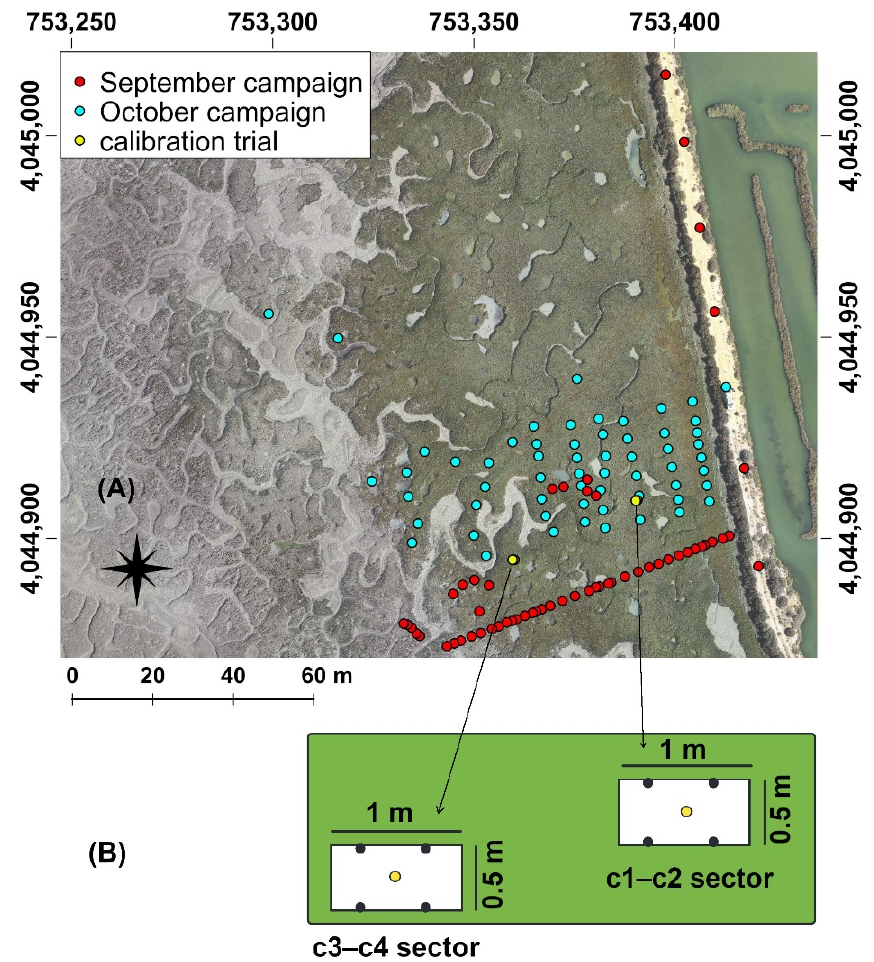
Figure 6. ( A ) Distribution of ground control points (GCP) over the surveyed area. The sectors for the calibration trial are identified by c1–c2 and c3–c4. ( B ) Trial operation scheme. White areas represent areas with vegetation removal. Black points indicate the location of canopy height measurements. Yellow points identify the location of dGPS measurements inside the trial areas.